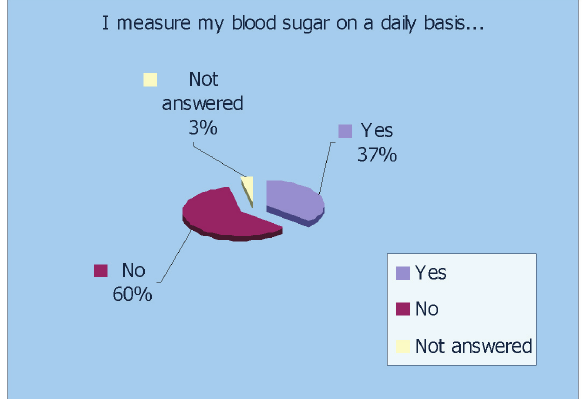
Figure 4. Patient measurement of blood sugar on a daily basis